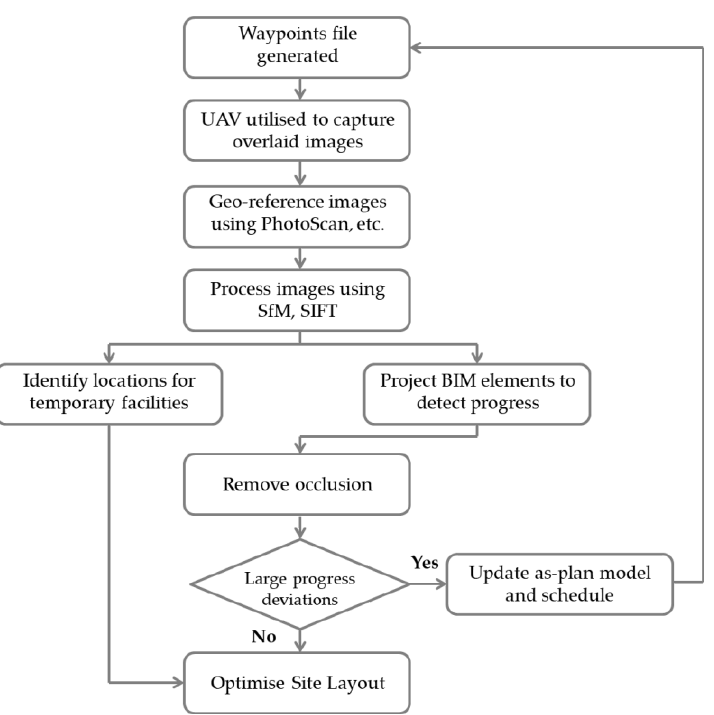
Figure 3. Flow chart depicting site layout updating process.